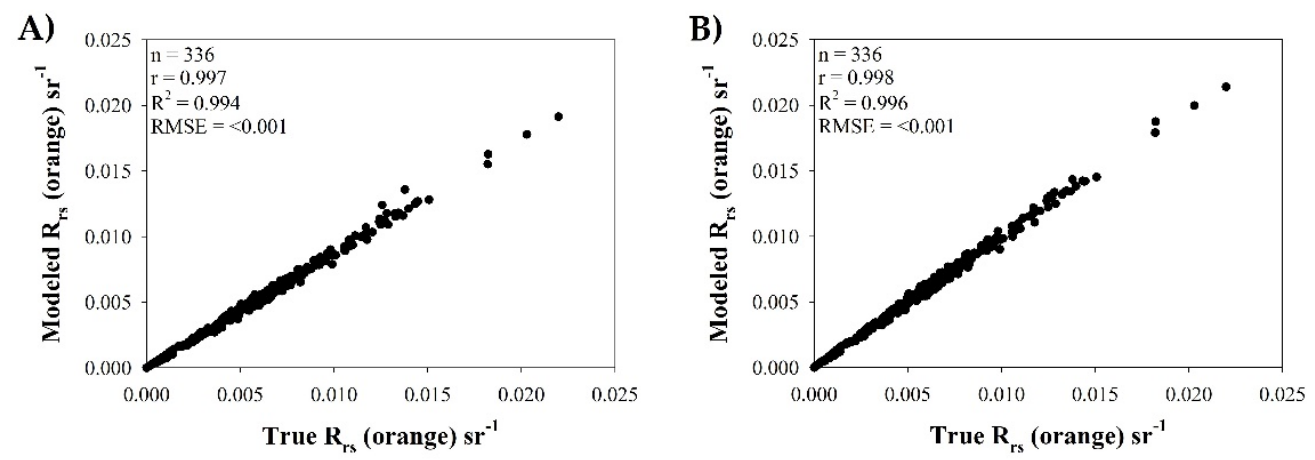
Figure 2. ( A ) Relationship between modeled R rs (orange) and True R rs (orange) based on the Castagna et al. [12] relationship (Equation (2)); and ( B ) Relationship between modeled R rs (orange) and True R rs (orange) based on multiple linear regression (Equation (3)).